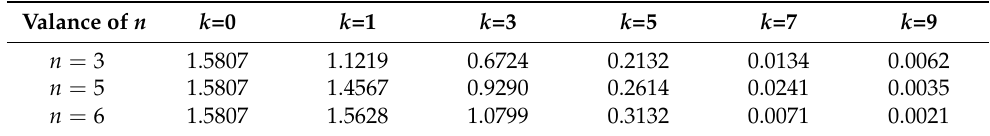
Table 1. The maximum angle between normal vectors of the extraordinary points with different